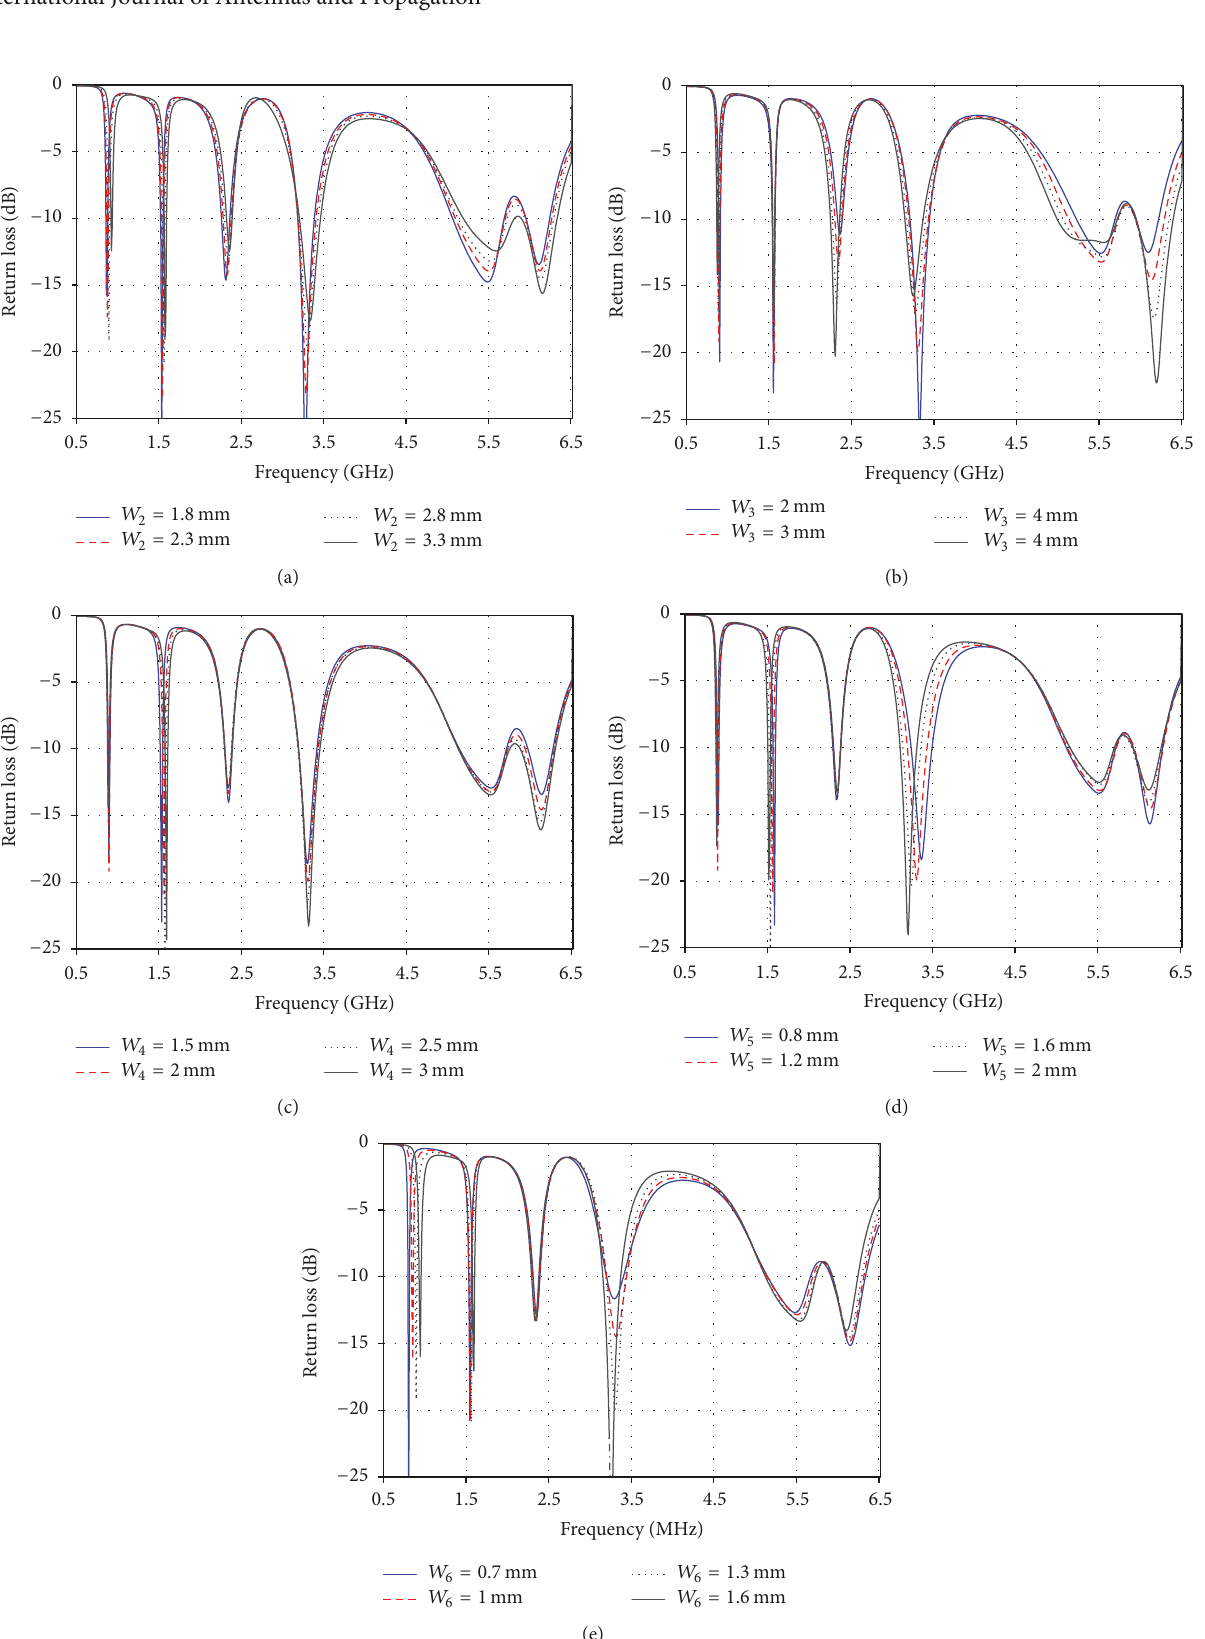
Figure 5: Simulated return loss of the proposed antenna with variations of widths 𝑊 2 (a), 𝑊 3 (b), 𝑊 4 (c), 𝑊 5 (d), and 𝑊 6